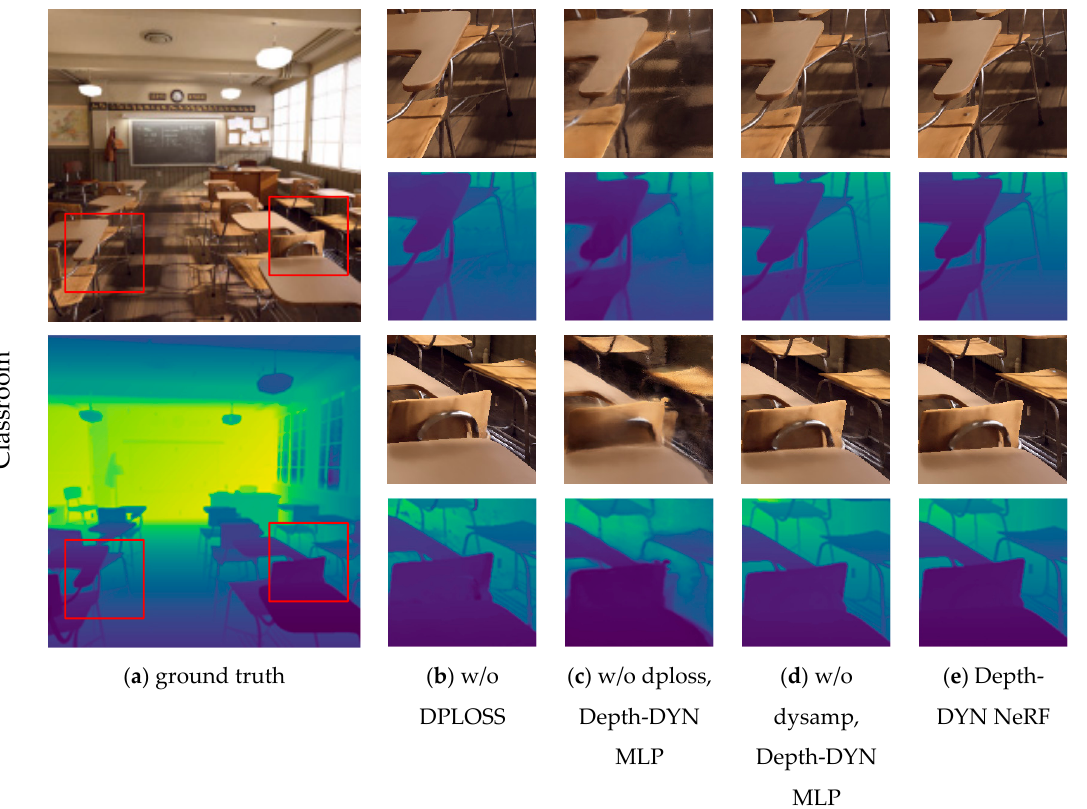
Figure A1. The rendered image of the Classroom scene and the depth of the test scene are compared with the real image and depth.